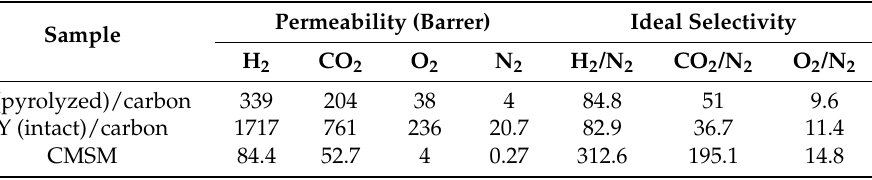
Table 8. The effect of channel integrity on the gas separation performance of the zeolite Y/carbon hybrid membranes [59].